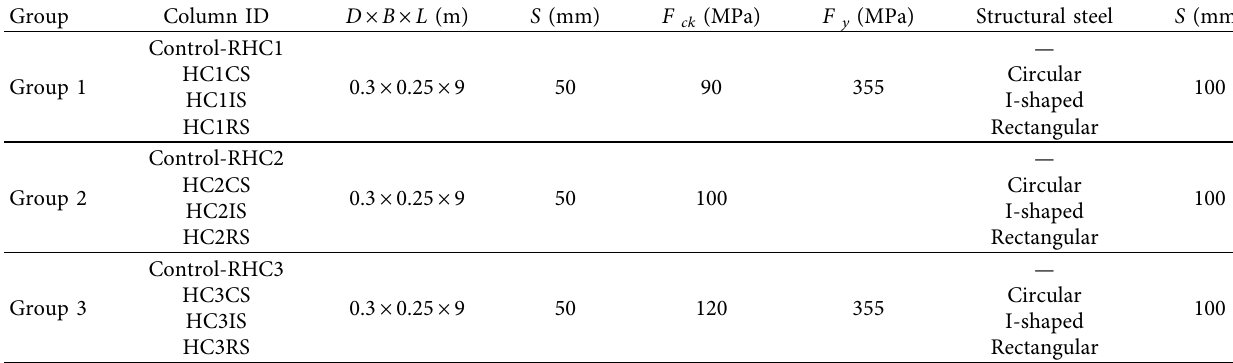
Table 6: Specimens for efects of structural steel encasements.